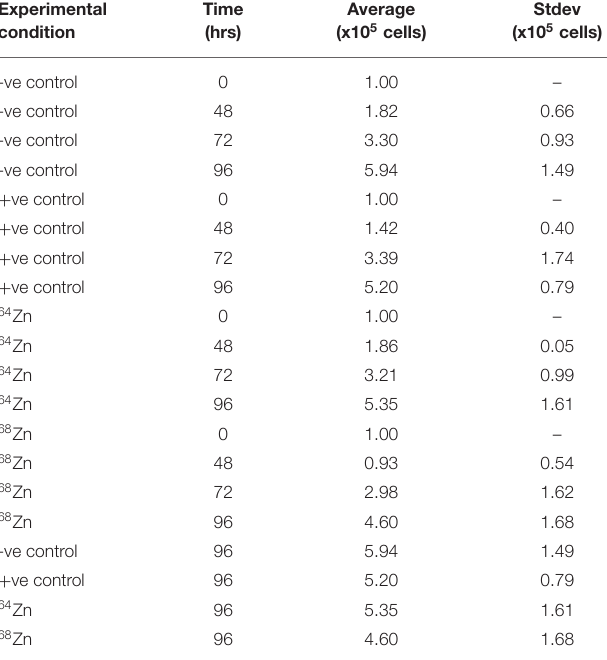
Cell Efflux TABLE 1 | Data summary for Zn isotope enrichment proliferation